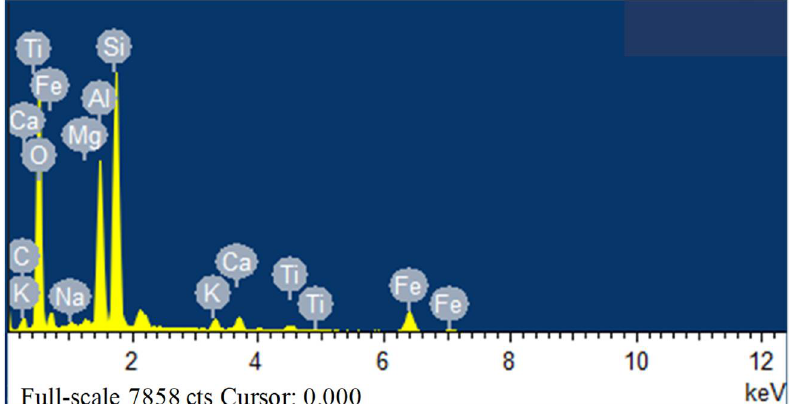
Figure 3. EDS analysis result for the cement.